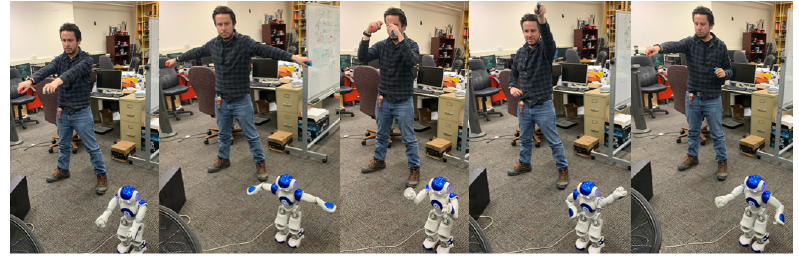
Figure 22. Process of imitation for NAO robot upper limb